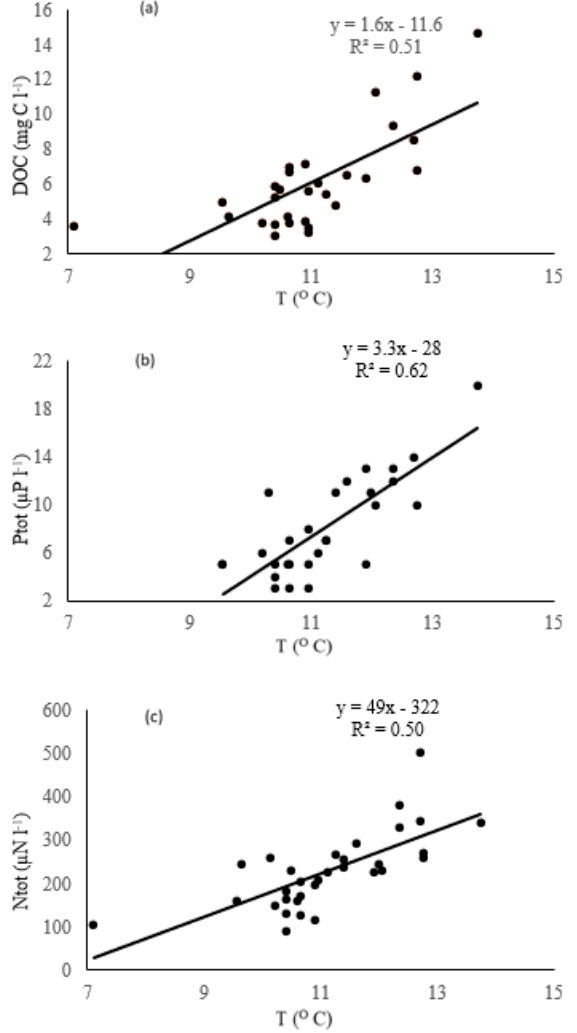
Figure 6. Dependencies between ( a ) dissolved organic carbon (DOC), ( b ) total P (P tot ), ( c ) total nitrogen (N tot ), and mean monthly surface air temperature (T) for a 28-year period (1990–2018) dots are values, lines are trends.